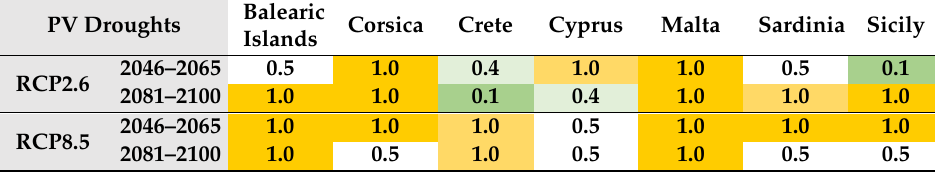
Table A6. Normalized uncertainty (Nu) for PV productivity droughts for each island, scenario and time period. Deep green cells: Nu = 0–0.2; Light green: Nu = 0.3–0.4; White: Nu = 0.5; Light